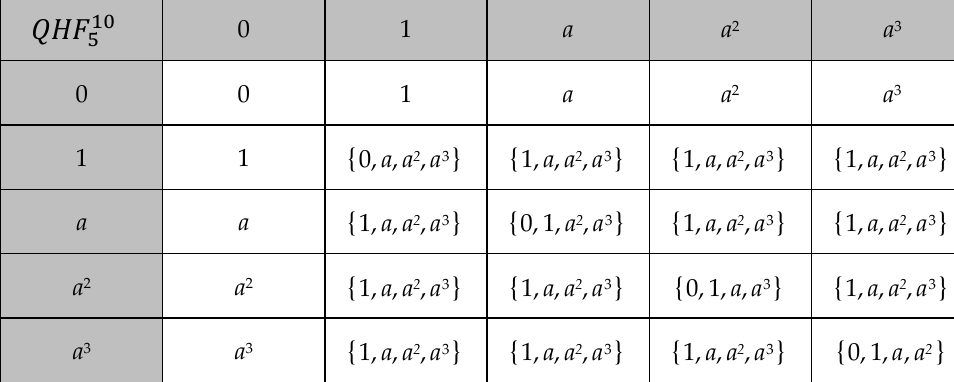
Table 22. The Cayley table of the additive canonical hypergroup of the quotient hyperfield